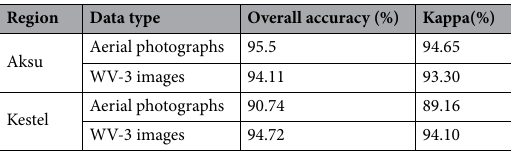
Table 3. The overall accuracy and Kappa statistics.